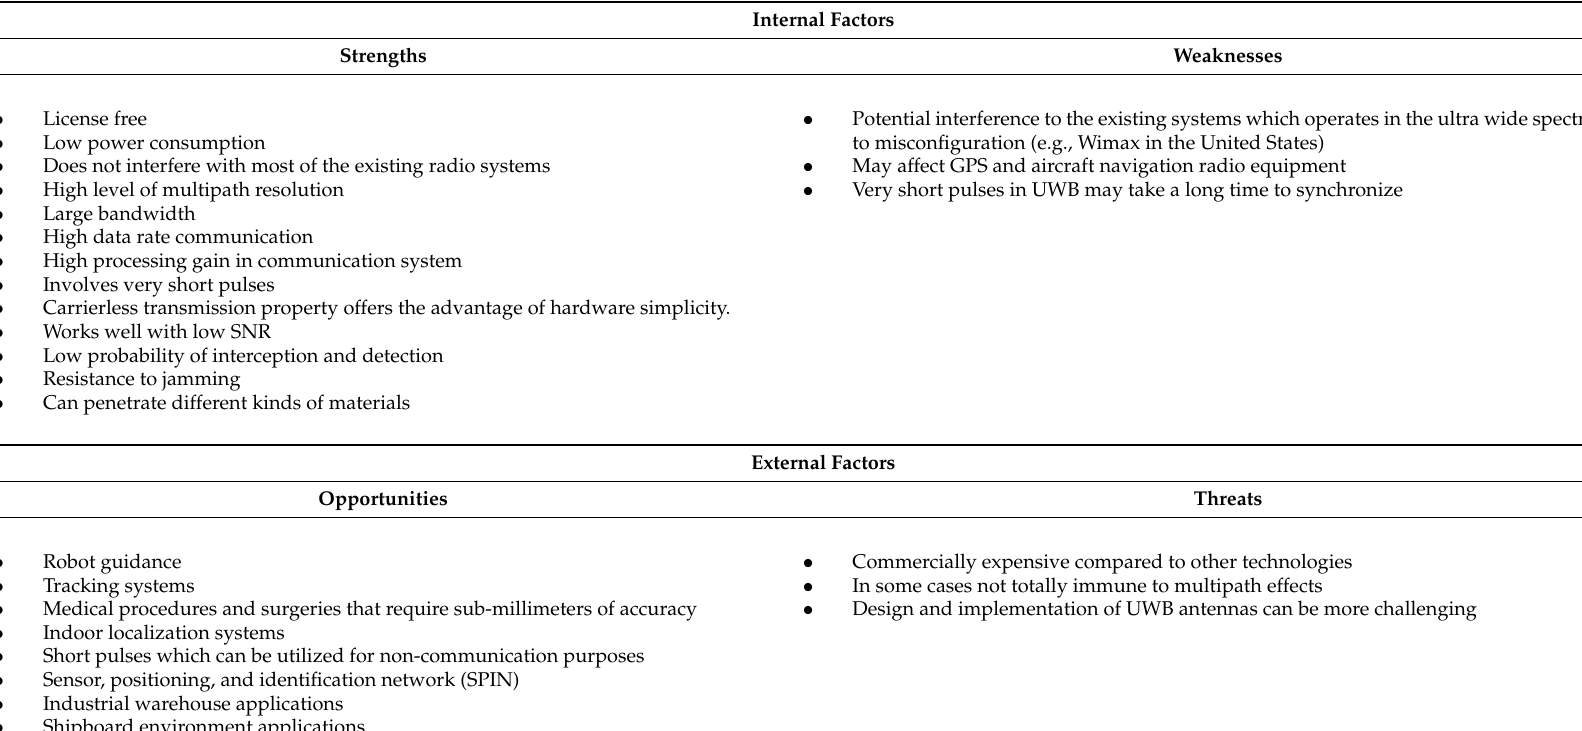
Table 9. Summary of strengths, weaknesses, opportunities, and threats (SWOT) analysis for UWB